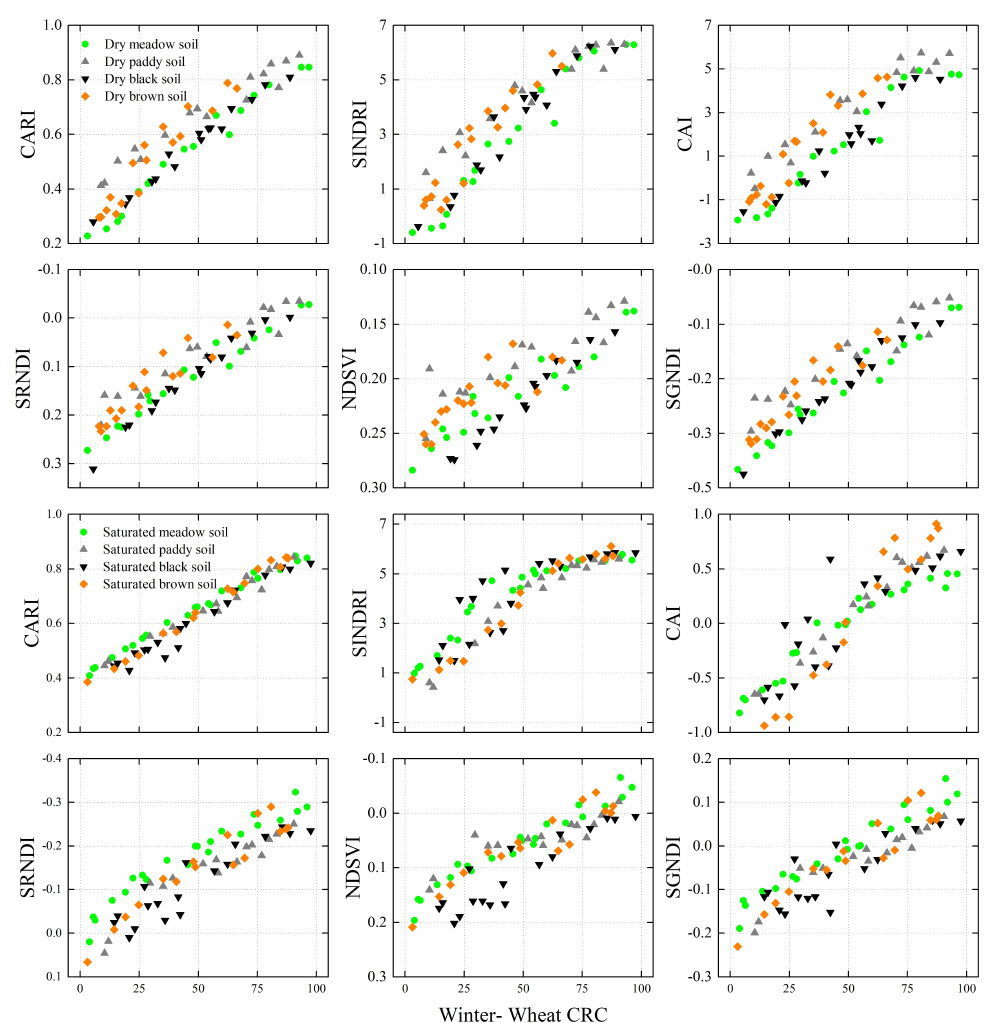
Figure 8. Correlation between spectral indices and winter-wheat CRC for four soil backgrounds at single moisture contents. single moisture contents. Note: For visualization, the ordinate of the six SIs may differ. Only dry and saturated samples of the calibration dataset were used ( n = 137), and the data were divided into four soil groups (paddy soil, black soil, meadow soil, and brown